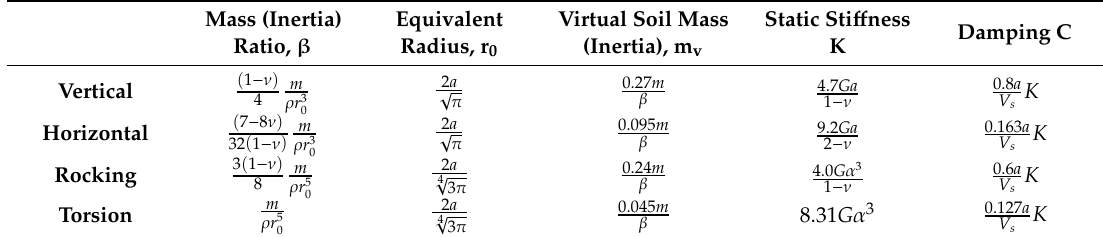
Table 2. Formulae for mass, springs, and dashpots (after [19]).